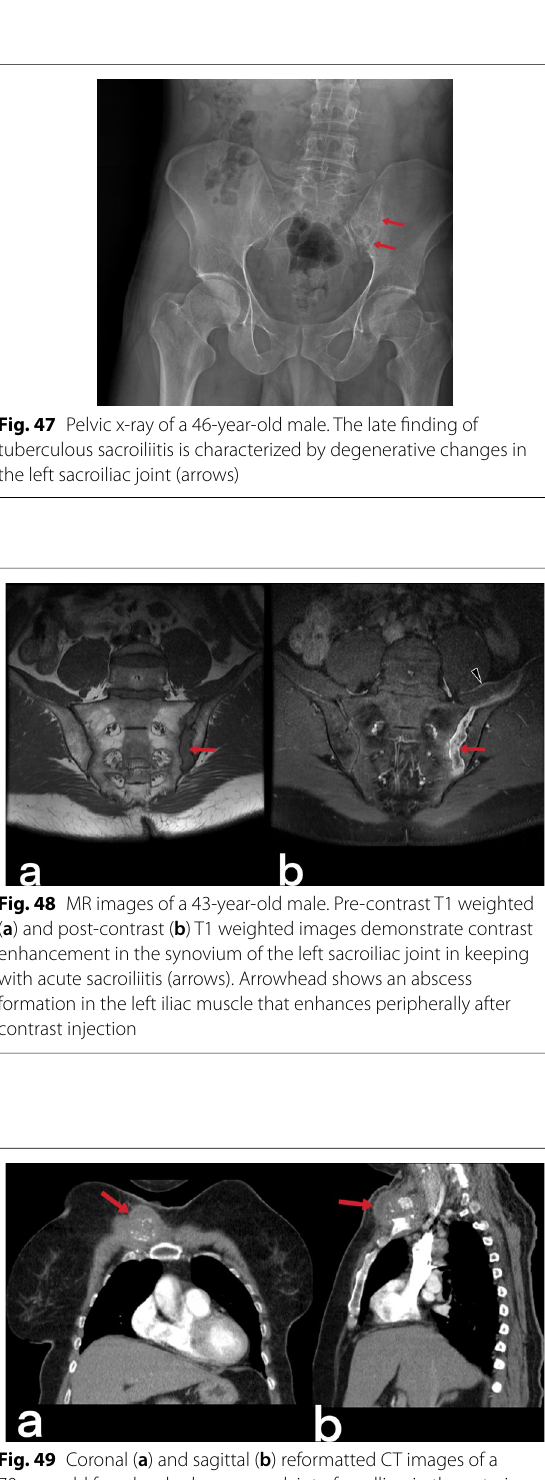
Fig. 49 Coronal ( a ) and sagittal ( b ) reformatted CT images of a 70-year-old female who has a complaint of swelling in the anterior wall of the chest. Both images reveal mass-like lesions in the right sternoclavicular joint, causing bone destruction containing small calcified areas. The patient was diagnosed with TB after the biopsy